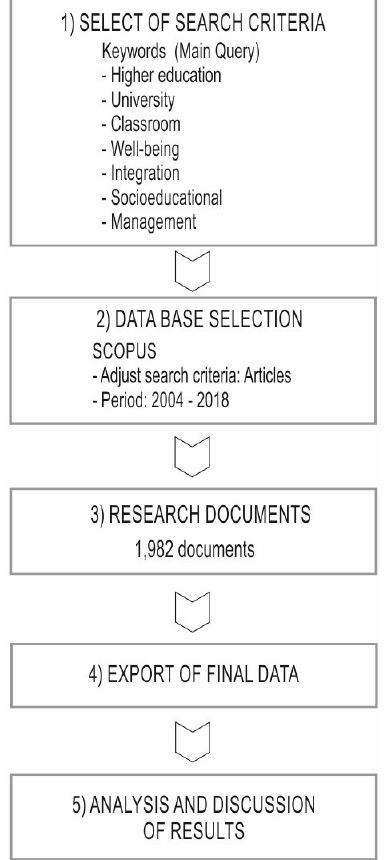
Figure 2. Flowchart of the protocol followed in the selection of documents.